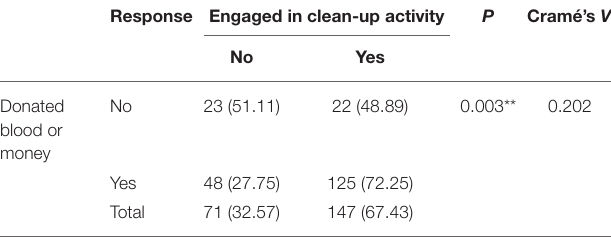
TABLE 1 | Association between volunteering in clean-up and social welfare. Response Engaged in clean-up